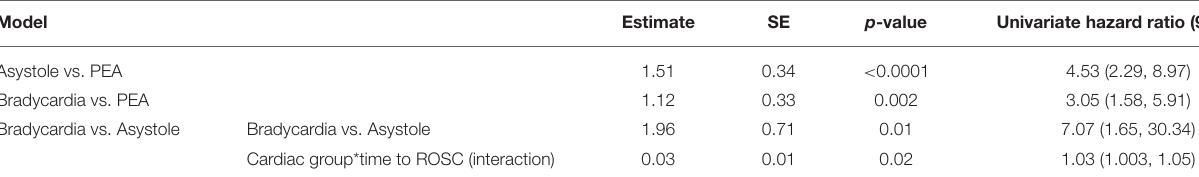
TABLE 3 | Cox Regression estimates of hazard ratios.